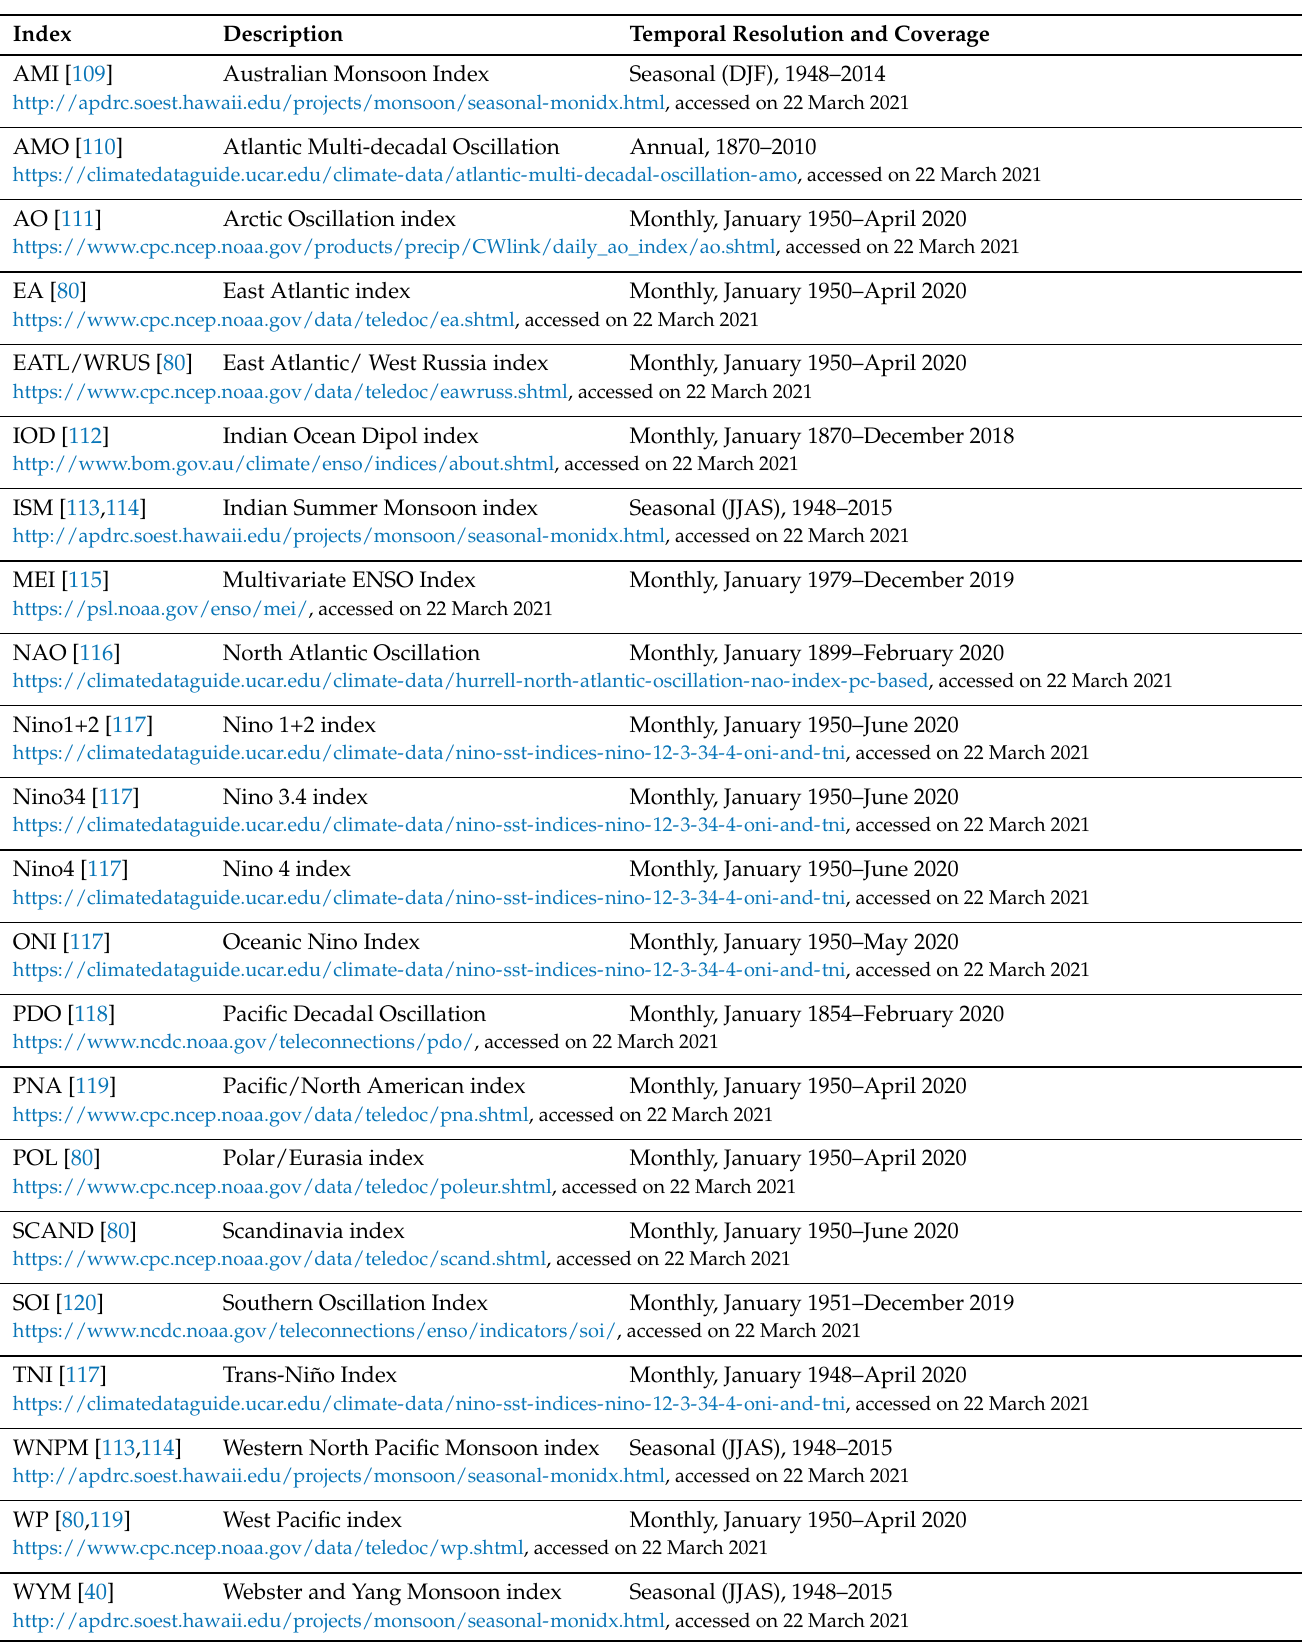
Table A1. Investigated circulation, oscillation and monsoon indexes; The temporal resolution and coverage (status 1 August 2020) are displayed in the third